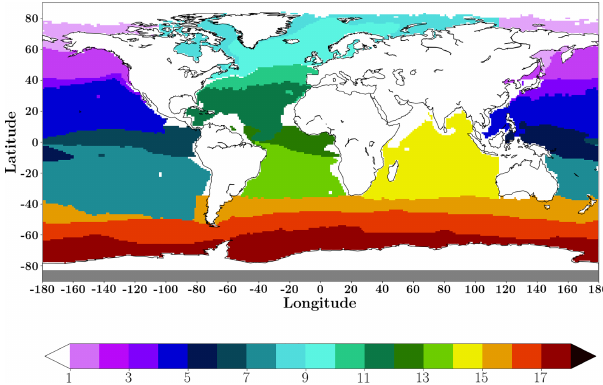
Figure 3. Map of biomes (following Rodenbeck et al., 2015; Fay and McKinley, 2014) used for comparison. See Table 2 for biome names.